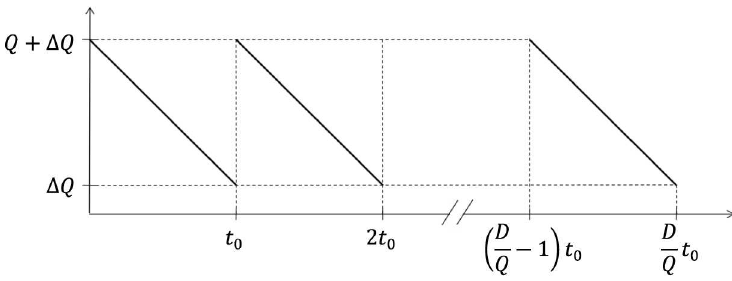
Figure 4. The level of inventory between successive